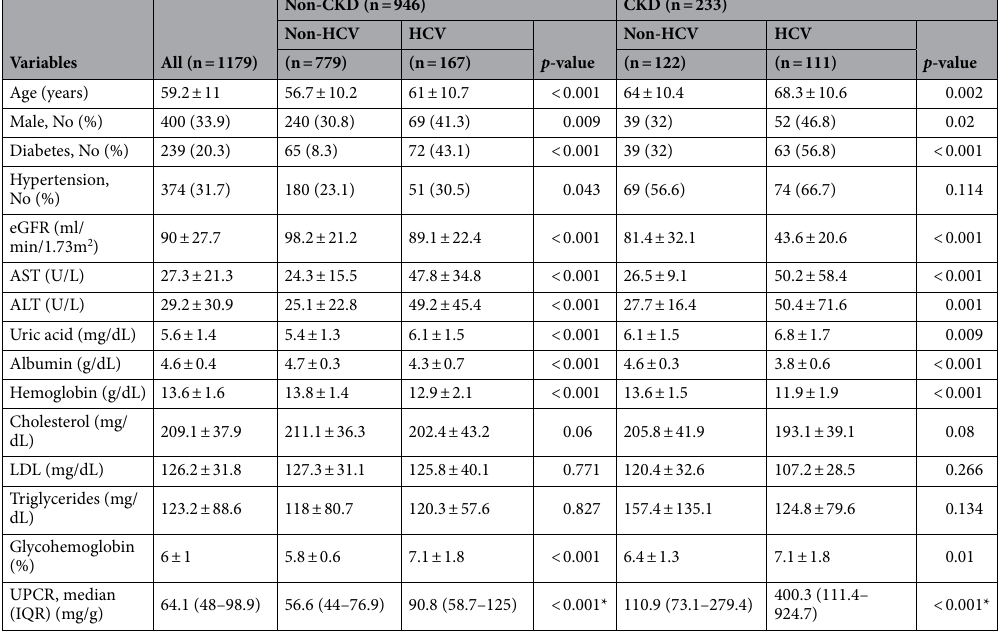
Table 1. Demographic characteristics of all patients stratified by CKD and HCV infection (n = 1179). ALT alanine aminotransferase, AST aspartate aminotransferase, CKD chronic kidney disease, eGFR estimated glomerular filtration rate, HCV hepatitis C virus, IQR interquartile range, LDL low-density lipoprotein, UPCR urine protein to creatinine ratio. * p -value using Mann–Whitney U